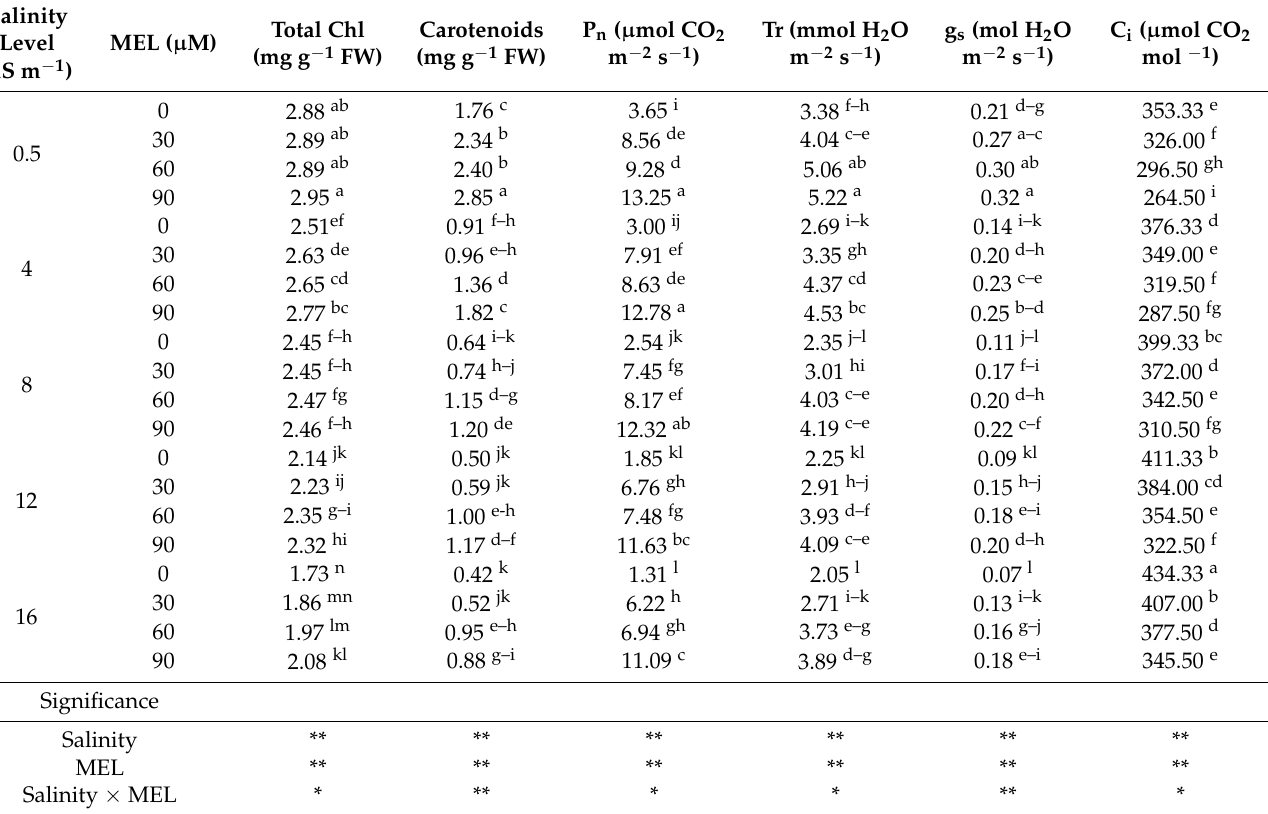
Table 1. Effects of MEL foliar applications (0, 30, 60 and 90 µ M) on the leaf photosynthetic pigment concentrations and gas exchange attributes of camelina grown under different levels of salinity (0.5, 4, 8, 12 and 16 dS m − 1